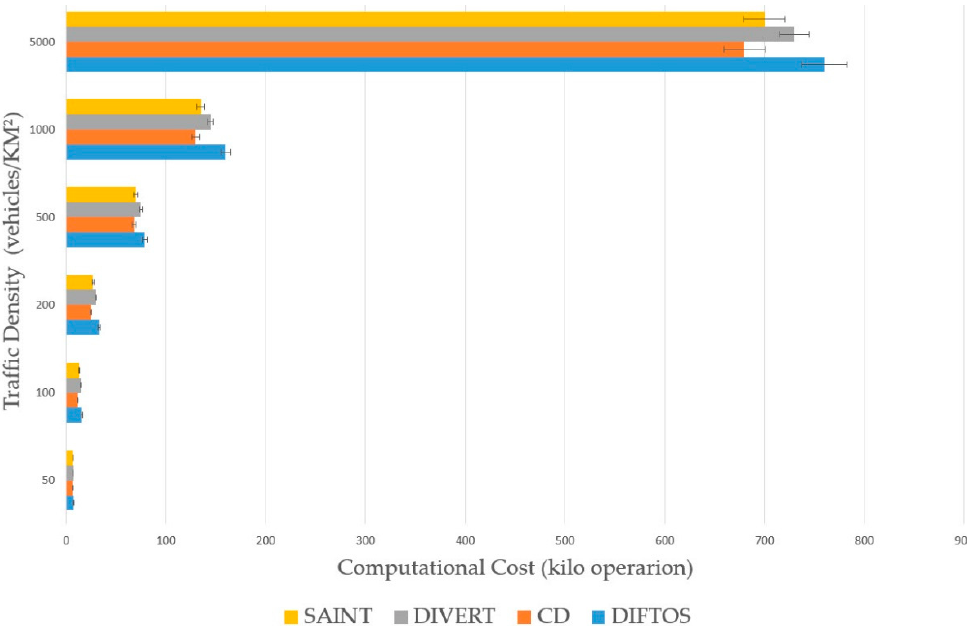
Figure 6. Traffic density vs. computational cost.